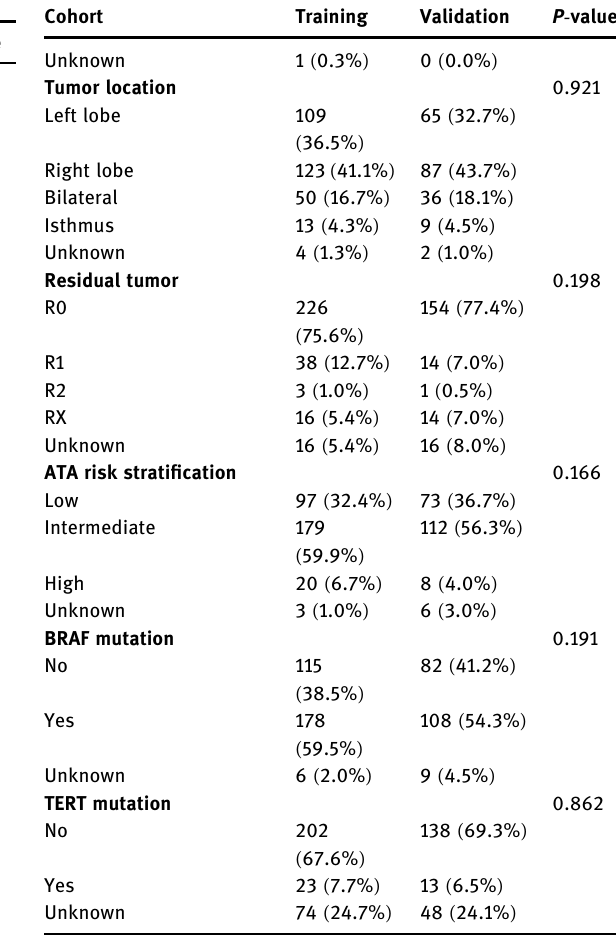
Table 1: Comparison of the clinical characteristics between the training and validation